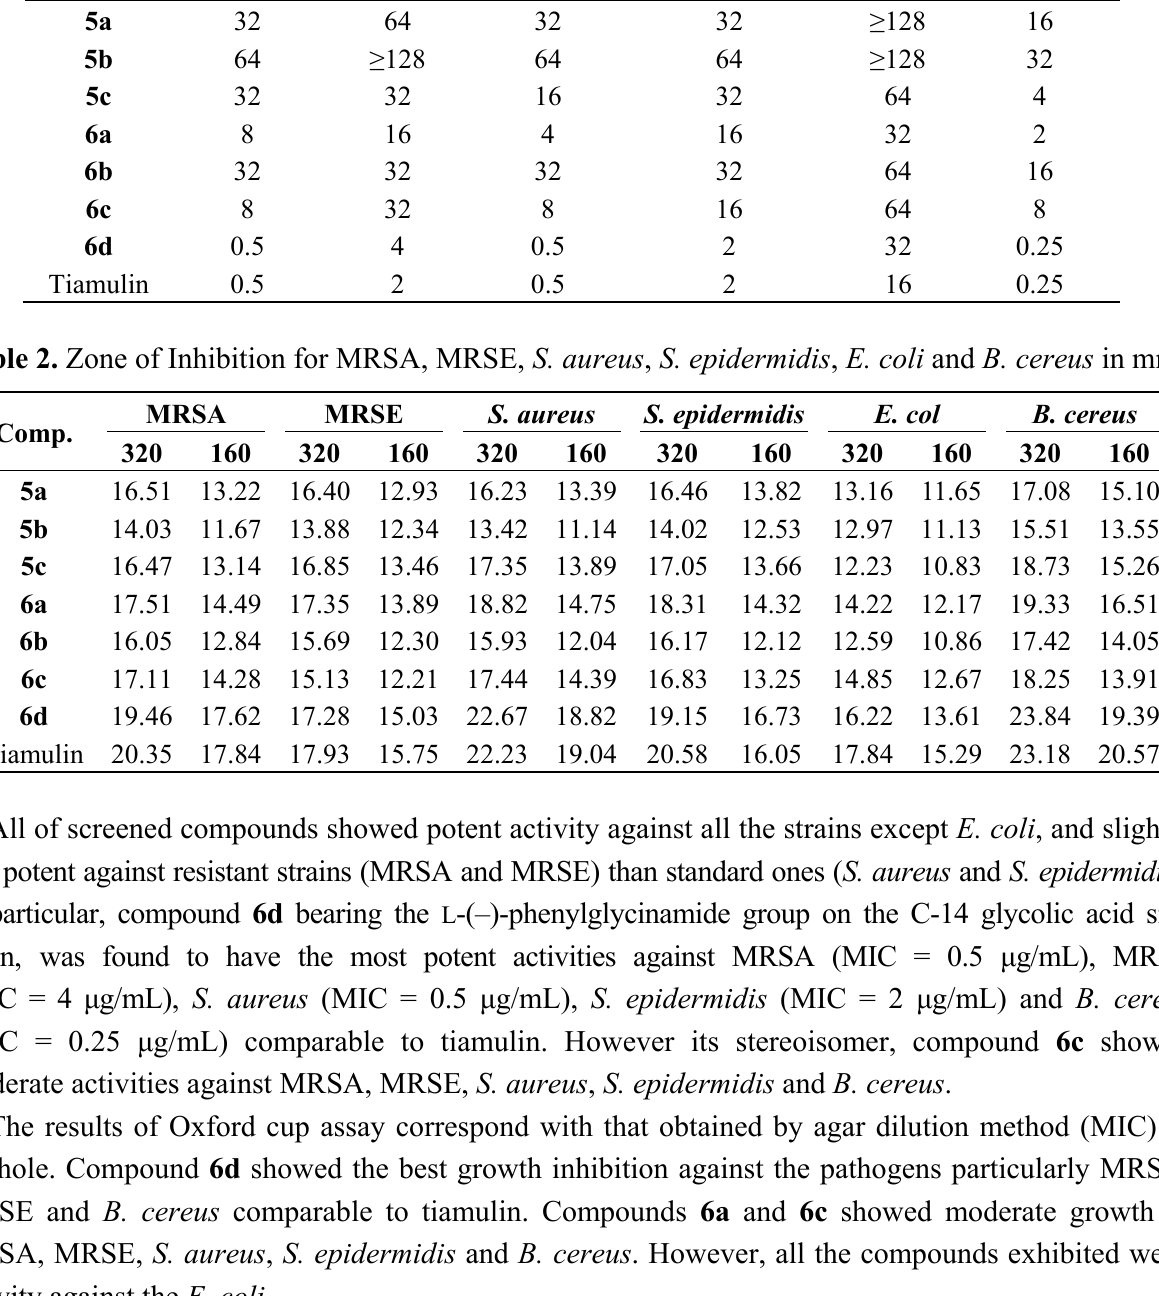
Table 1. Antibacterial activity (MIC) of the synthesized pleuromutilin derivatives. Comp.